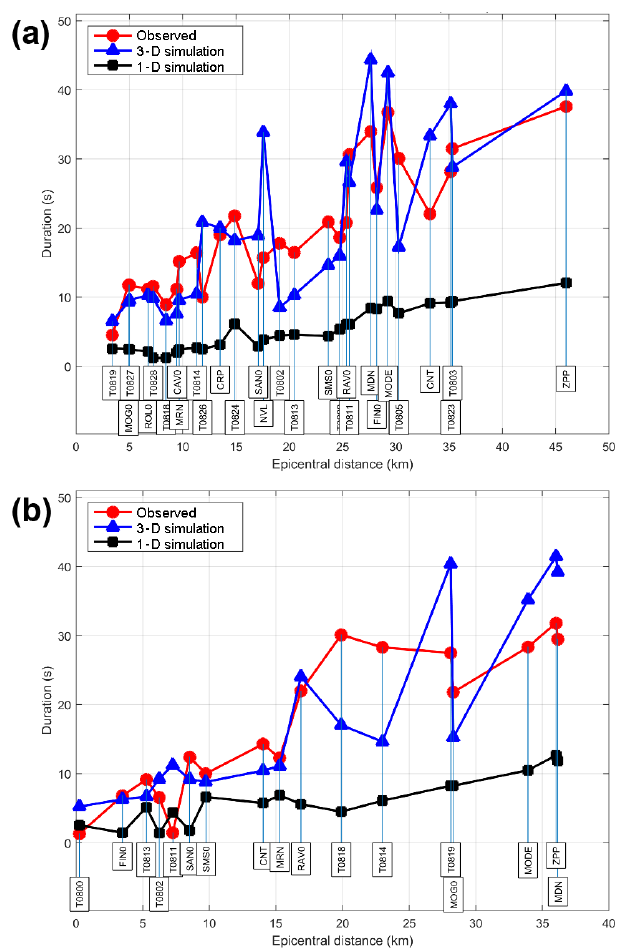
Figure 9. Observed and numerically simulated duration (defined as intervals between 5% and 95% of the Arias intensity) at the considered stations, plotted in function of the epicentral distance. (a) The 12 June 2012 M W 4.1 event. (b) The 23 May M W 4.0